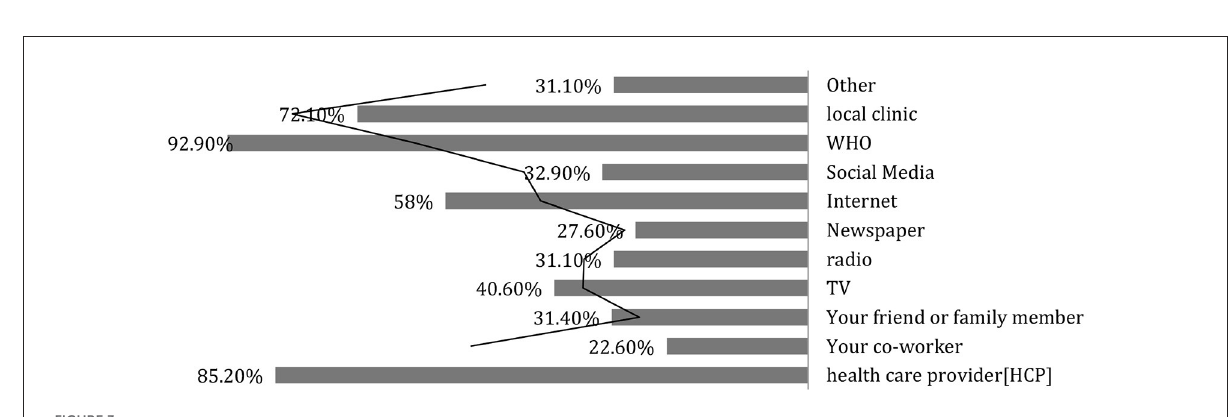
FIGURE3 Where would the parents like to get information about the COVID19